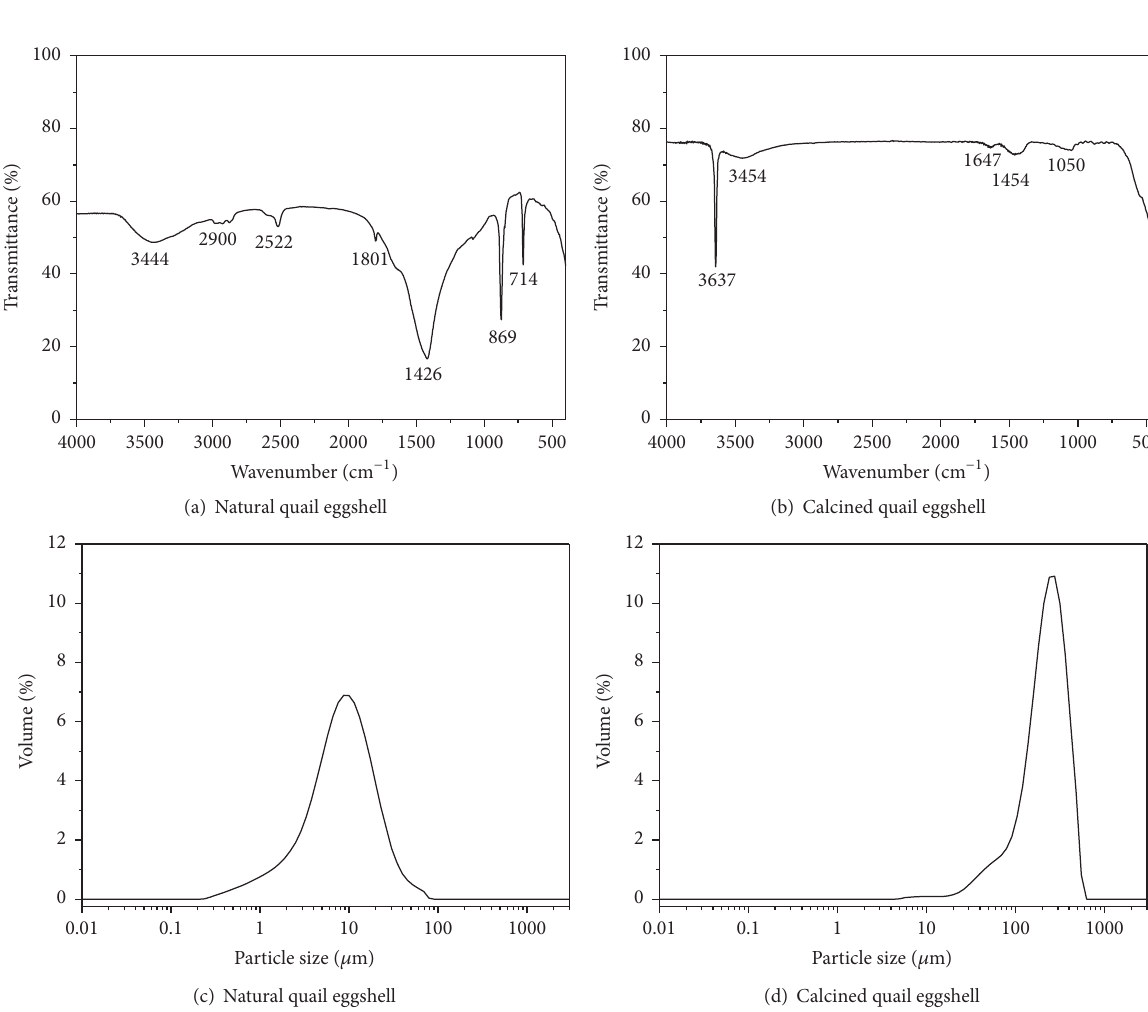
Figure 3: FTIR spectra ((a) and (b)) and distribution particle sizes analysis ((c) and (d)) of natural and calcined quail eggshell.